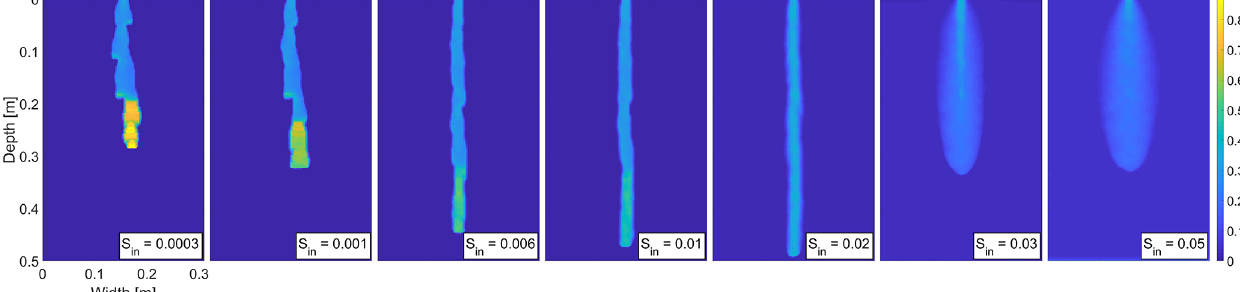
Figure A3. Snapshot of the saturation field at 25min for seven different values of the initial saturation for the distribution which satisfies κ max /κ min ≈ 2 . 60 (the distribution in Fig. A2a). Saturation values are color coded according to the color bar on the right.